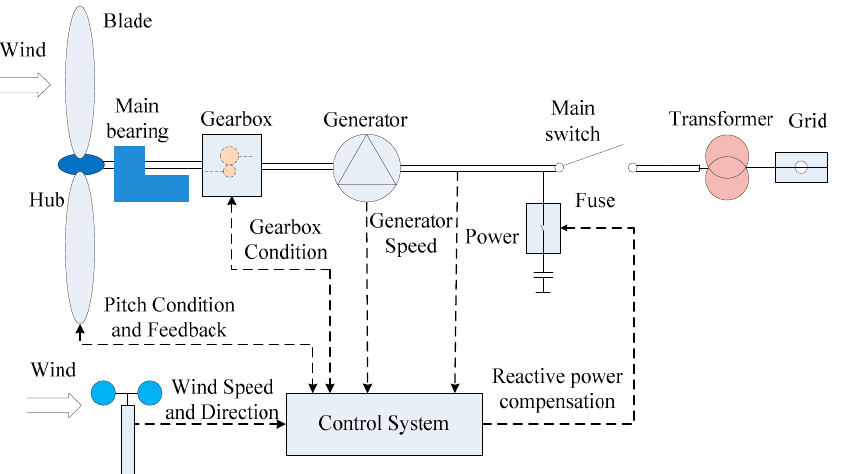
8 of 14 Figure 2. Gearbox fault diagnosis flowchart. 3.1. Data Description The operation data of a 1.5 MW wind turbine in a wind farm in Inner Mongolia was used in this experiment. This wind farm contains 33 wind turbines. The data of a wind turbine with a gearbox fault, chosen through random selection, was used. The data in- terval was 1 min. For the rigor of the experiment, this experiment selected the data 5 h